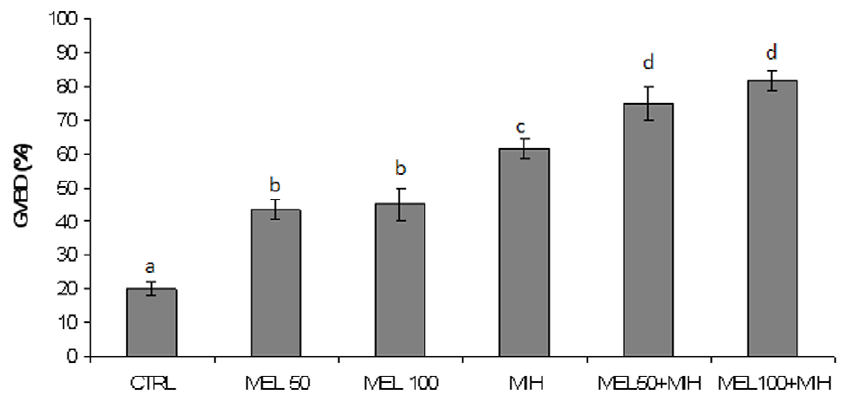
Figure 6. Invitro effects of melatonin on oocyte maturation. GVBD rate in class IIIB oocyte exposed to 50 and 100 pg/ml of melatonin alone or in combination with the MIH. Error bars indicate the raw data mean 6 SD. Different letters indicate statistically significant differences (P , 0.05), after transformation of raw data in arcosin, analyzed by using ANOVA followed by Bonferroni’s multiple comparison test.